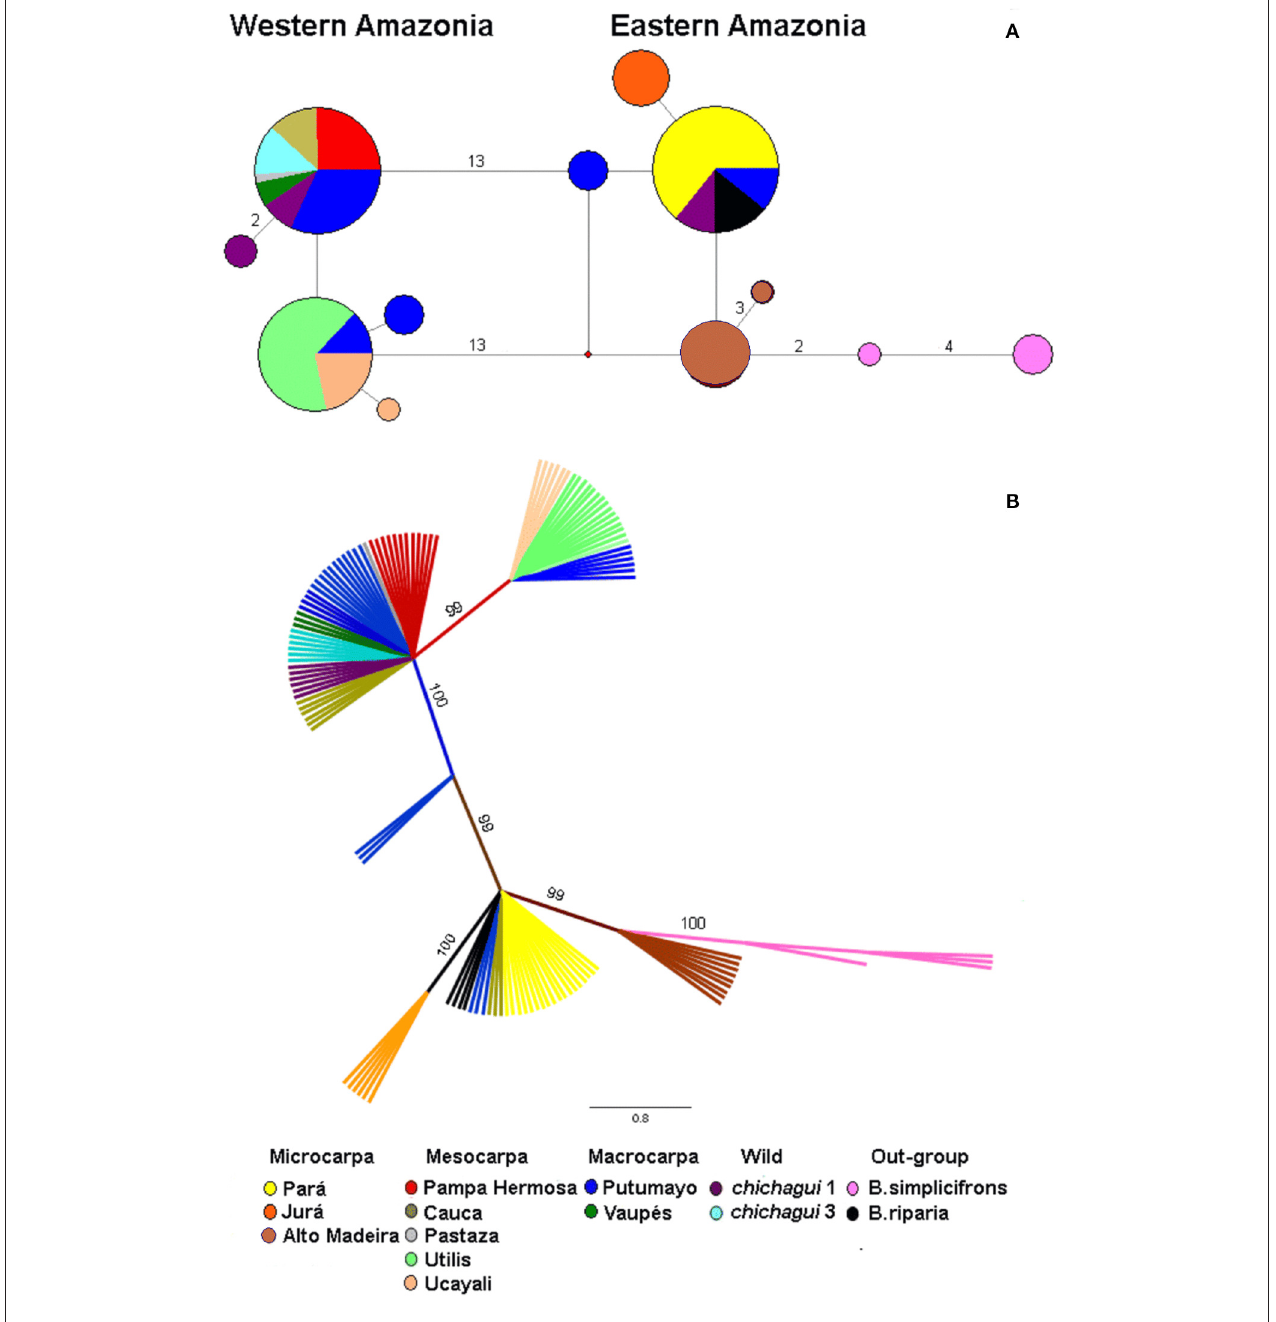
FIGURE 6 | Relationships among 126 plants in the peach palm ( Bactris gasipaes ) Core Collection based on the psbJ-petA chloroplast sequence. (A) Haplotype network estimated with maximum parsimony analysis and the Median Joining algorithm (redrawn from Cristo-Araújo et al., 2013). Circle size is proportional to the number of plants with the haplotype. The numbers next to each connecting line represent the number of mutations between haplotypes; lines with no number represent one mutation. The red dot represents a median vector, a haplotype that is assumed to exist but was not found in this set of plants. (B) Phylogenetic tree derived from Bayesian analysis. The numbers next to each connecting line represent the bootstrap estimate of confidence.